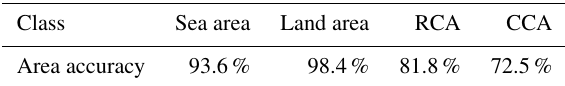
Table 3. Area accuracy assessment of different classes based on randomly selected